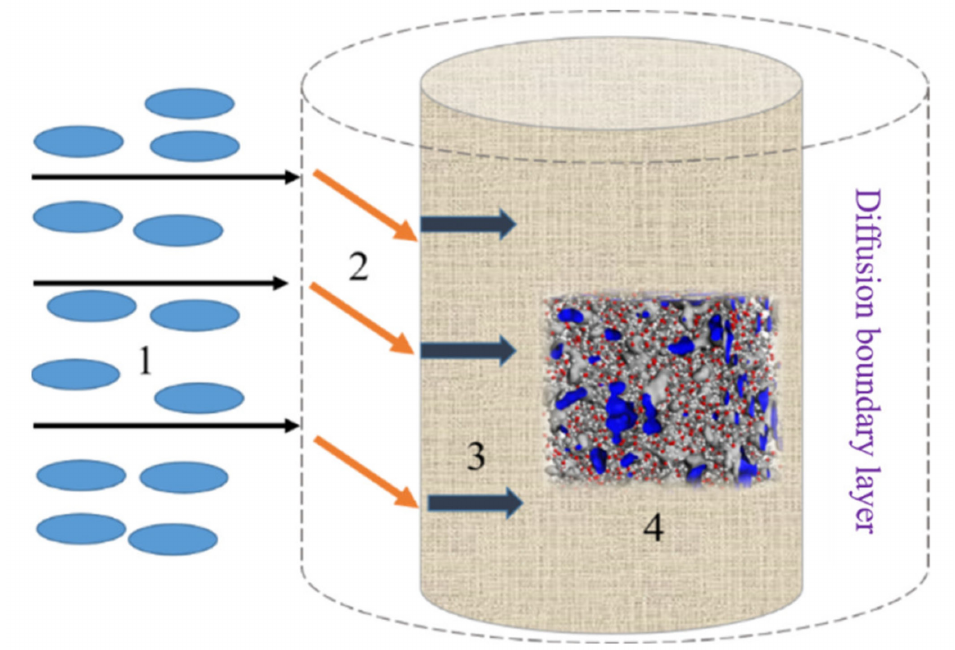
Figure 1. Molecular diffusion model. 1. Diffusing to the fiber surface boundary layer; 2. Being absorbed by the surface of cotton fiber; 3. Diffusing into the fiber; 4. Cross-linking with cellulose and fixing in the